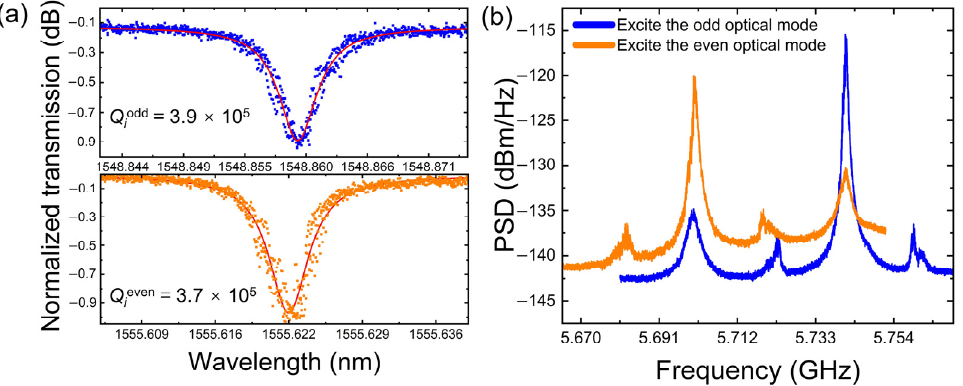
Figure 4. ( a ). Transmission spectra of first-order optical odd and even modes. ( b ). Power spectrum density (PSD) of mechanical spectrum analyzed by ESA for exciting odd and even optical modes, respectively.